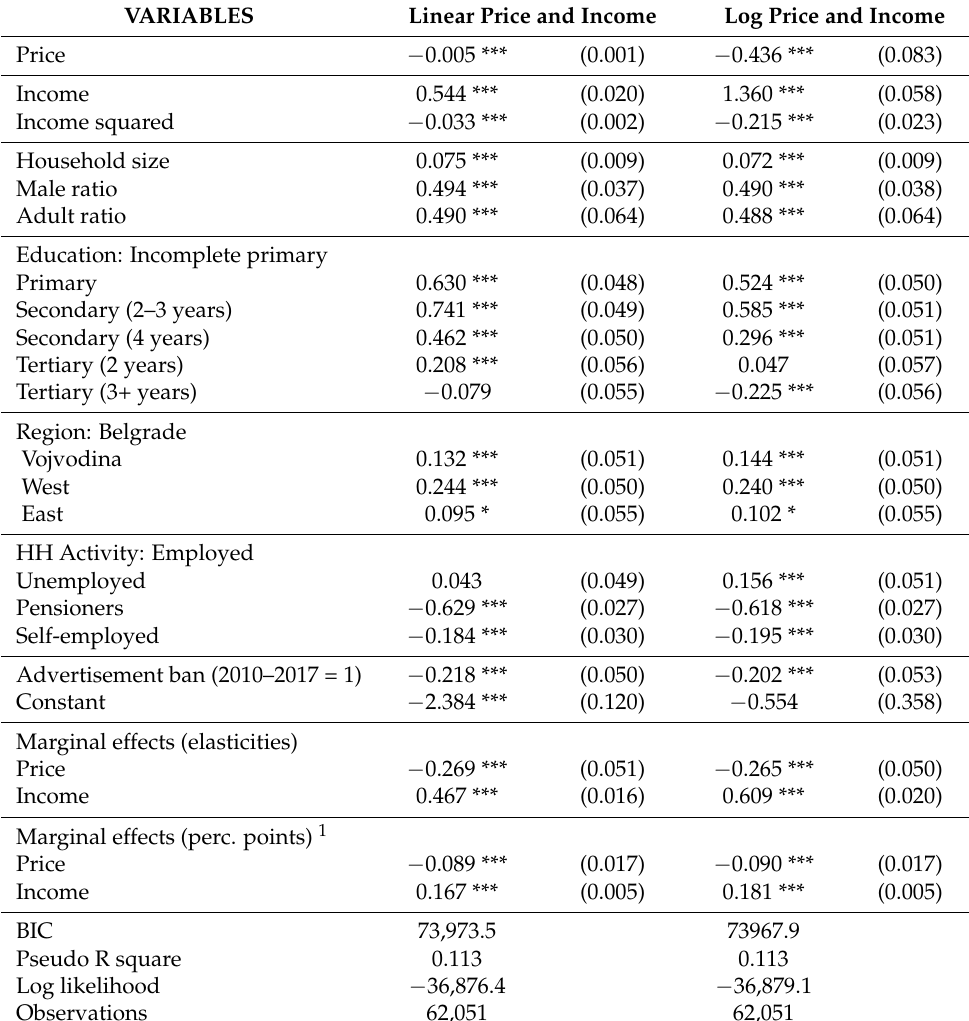
Table A1. Smoking prevalence model (different